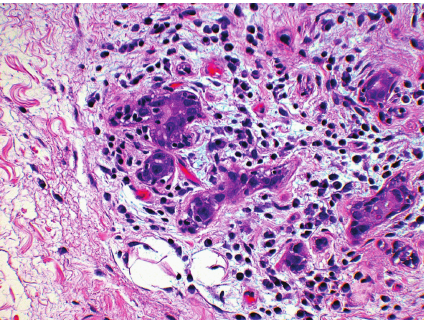
Figure 6: No-amifostine (HE, Original magnification × 4.8). Sub- mandibular gland of no-amifostine patient reveal di ff use (black arrow) and focal chronic inflammation (arrowhead), acinar atro- phy, di ff use fibrosis and dilation of ductal